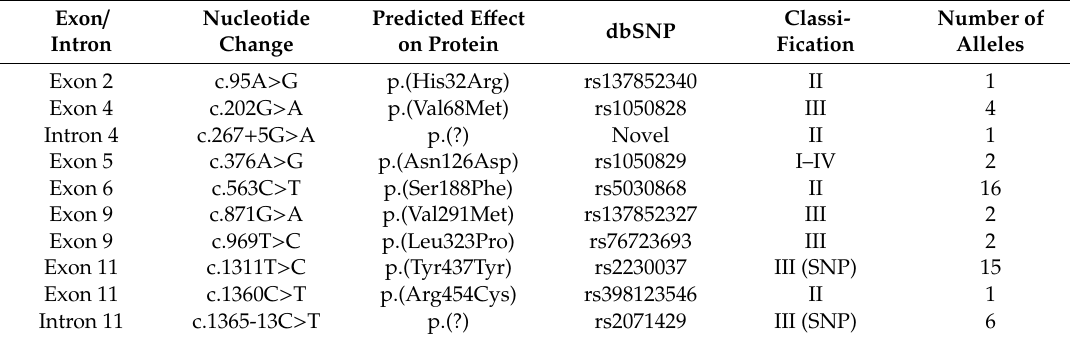
Table 2. Glucose-6-phosphate dehydrogenase gene variants detected in the screened